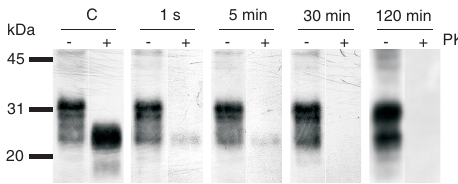
Figure 1. Influence of pressure-holding time on the re- sistance of PrP Sc to proteinase K (PK). Immunoblot detection of native hamster PrP Sc with the 3F4 anti- body. Samples were pressurized in phosphate-buffered saline, pH 7.4, at 800 MPa, 60 º C, for 1 s, 5, 30, and 120 min. Samples were incubated with (+) or without (-) PK. C = control. Table 1. Incubation period and titer of pressurized samples in bioassay.